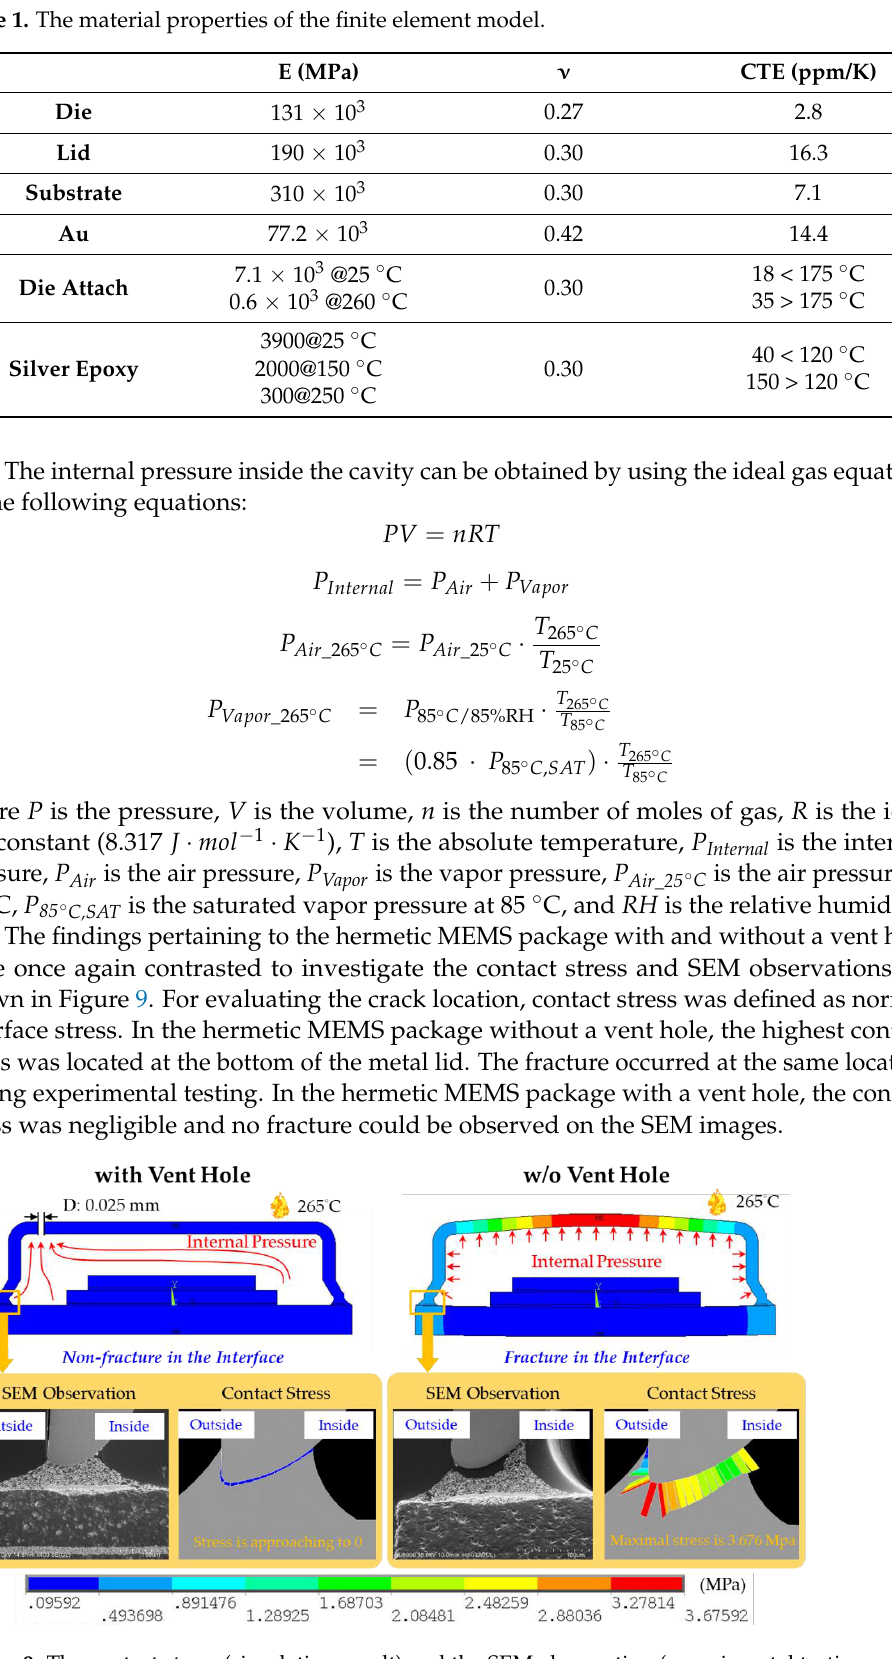
Figure 9. The contact stress (simulation result) and the SEM observation (experimental testing result) of the hermetic MEMS package with a vent hole and without a vent